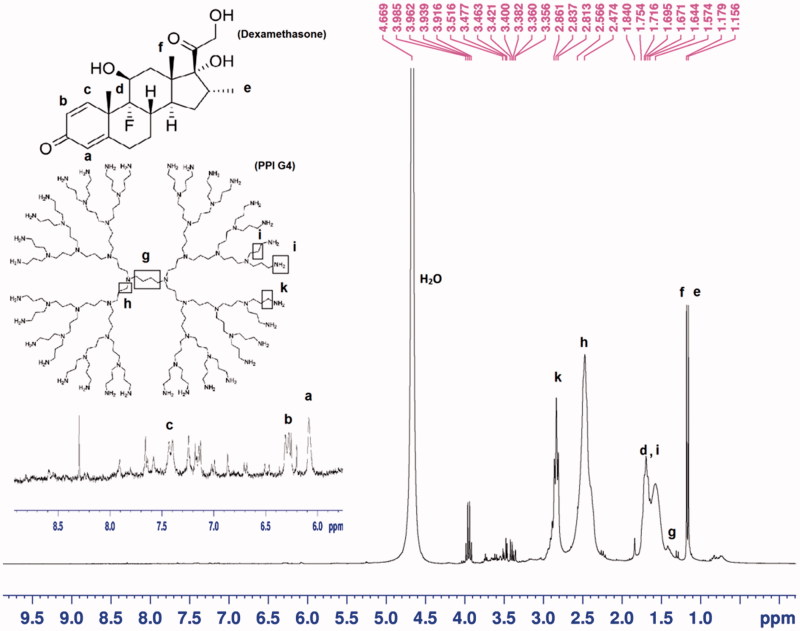

1H-NMR of PPI-Dexa.